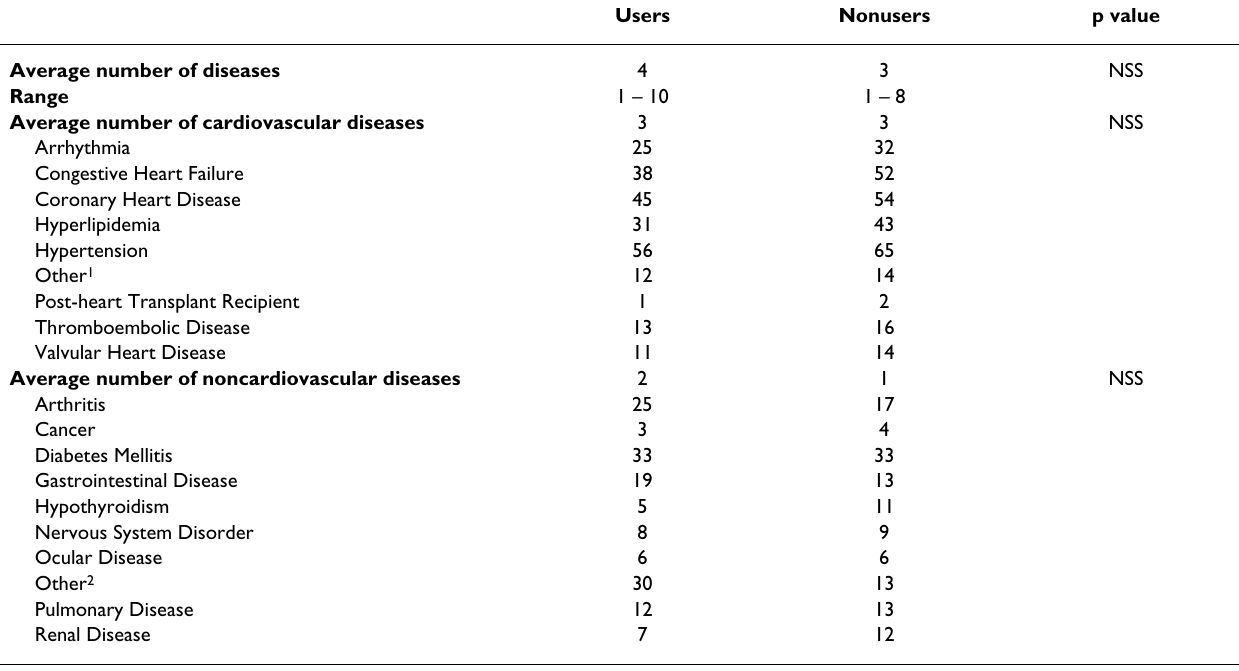
Table 2: Distribution of Cardiovascular and Noncardiovascular